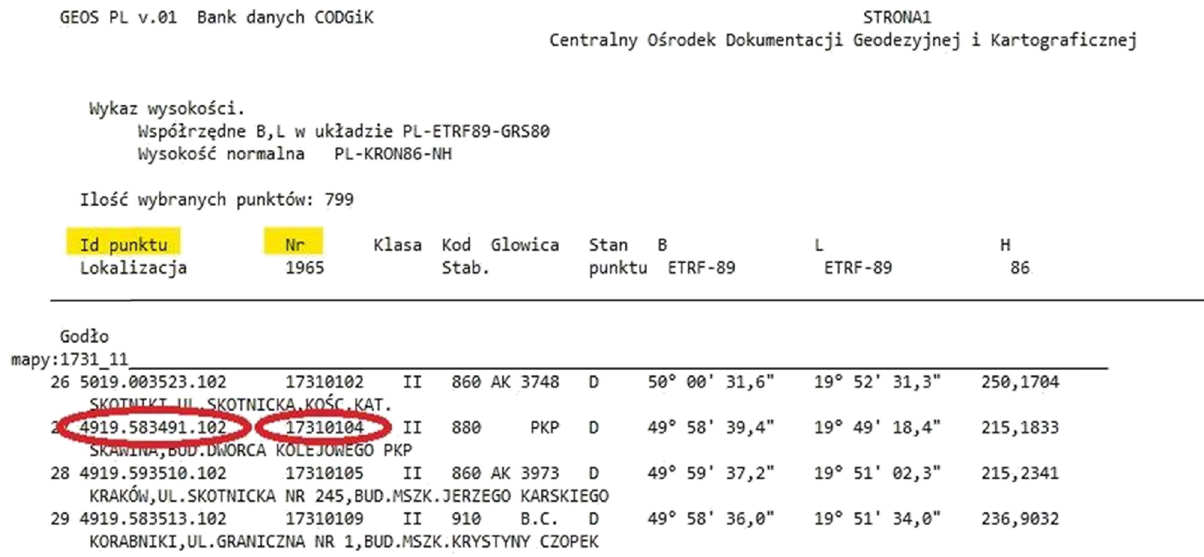
Figure 4: Fragment of data fi le retrieved from ZGiK. Source: ZGiK, 2019.